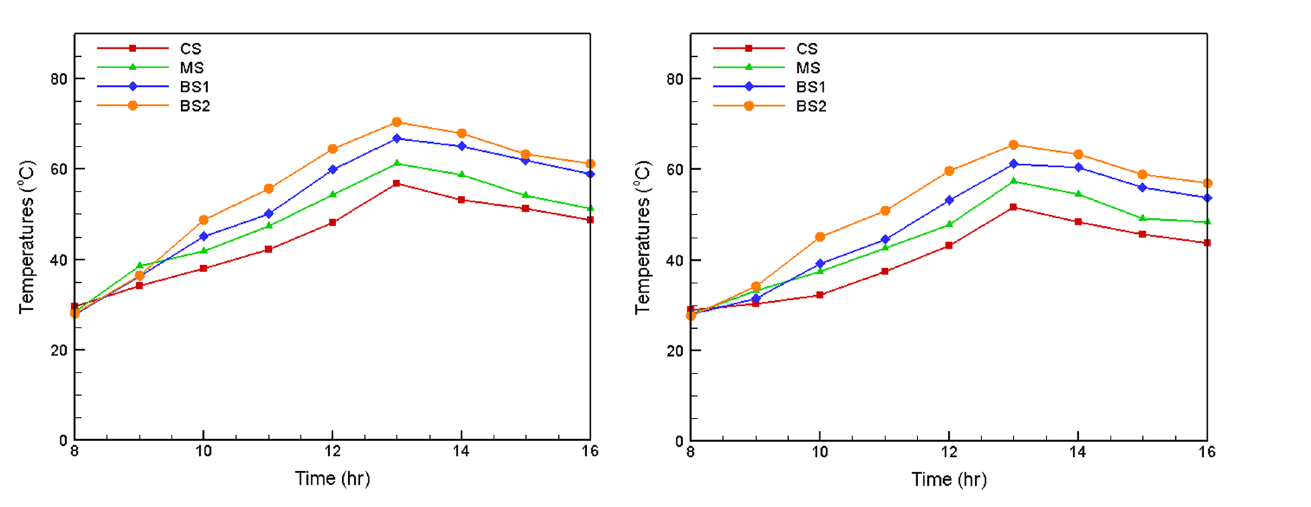
Figure 10: Variation of vapor temperatures with time.